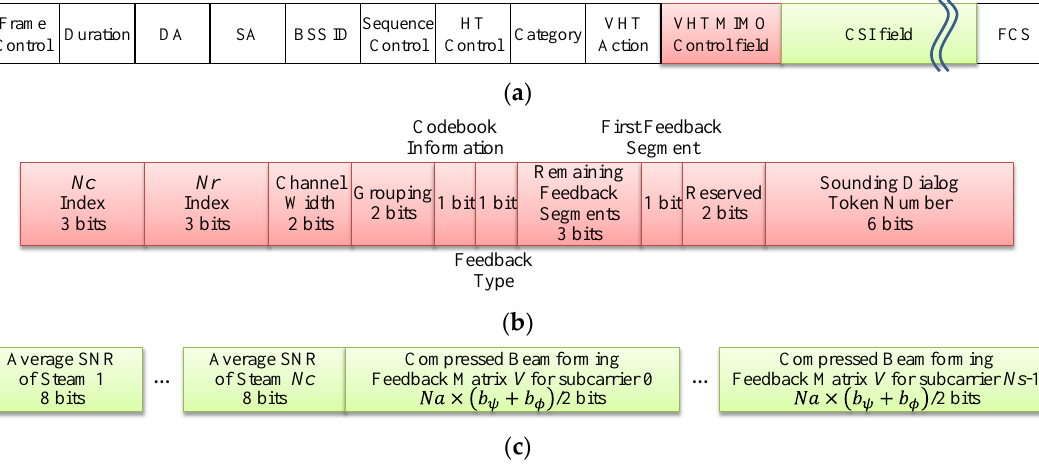
Figure 2. Configuration of the VHT compressed beamforming frame. ( a ) Frame structure on MAC layer; ( b ) VHT MIMO Control field; ( c ) CSI field.